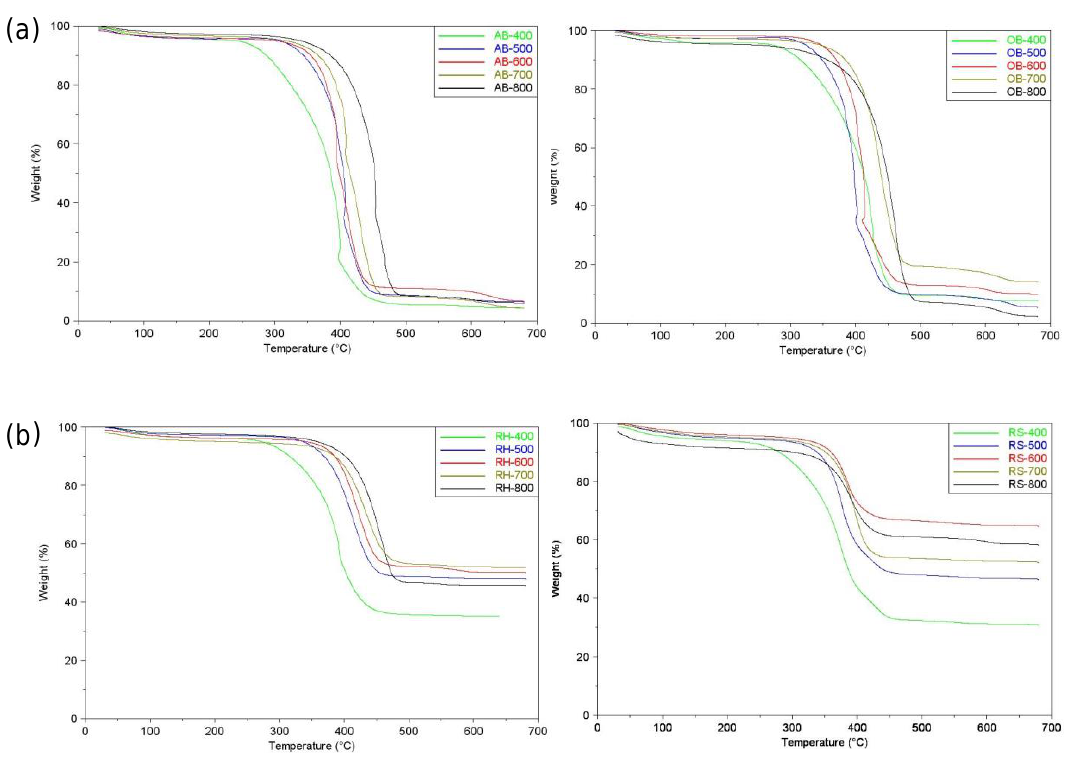
Figure 2. Thermal analysis of the biochars obtained from (a) wood materials (apple tree branch (AB) and oak tree (OB) as well as (b) rice residues (rice husk (RH) and rice straw